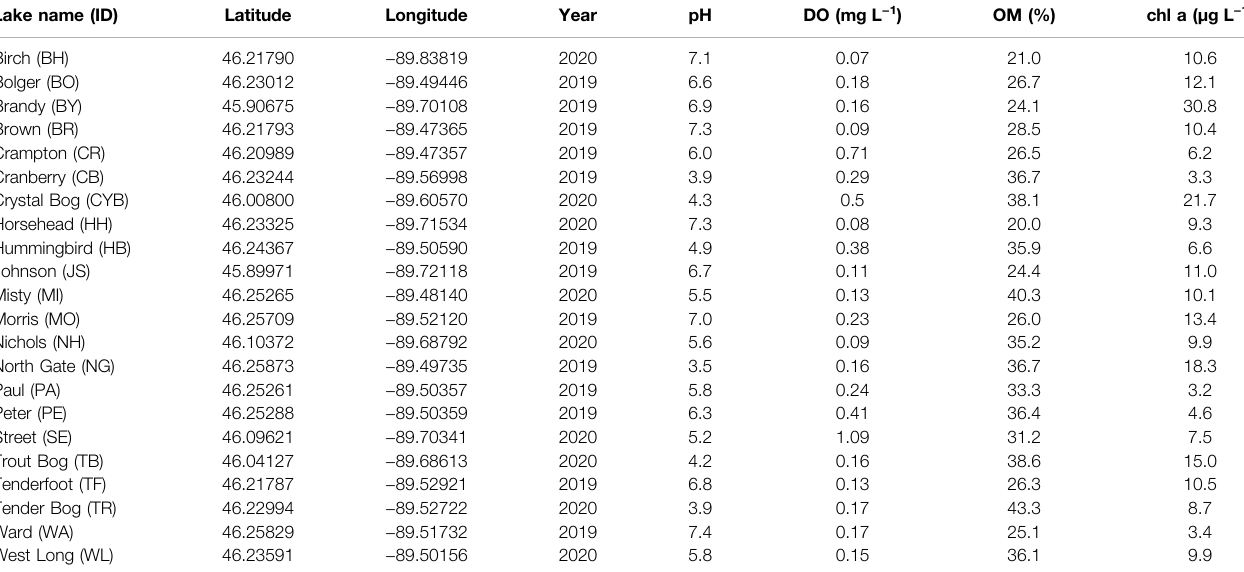
TABLE 1 | Summary of environmental variables of sampled lakes, including pH and dissolved oxygen (DO) concentration at the sediment-water interface, sediment organic matter content (OM %), and epilimnion chlorophyll a concentration (chl a